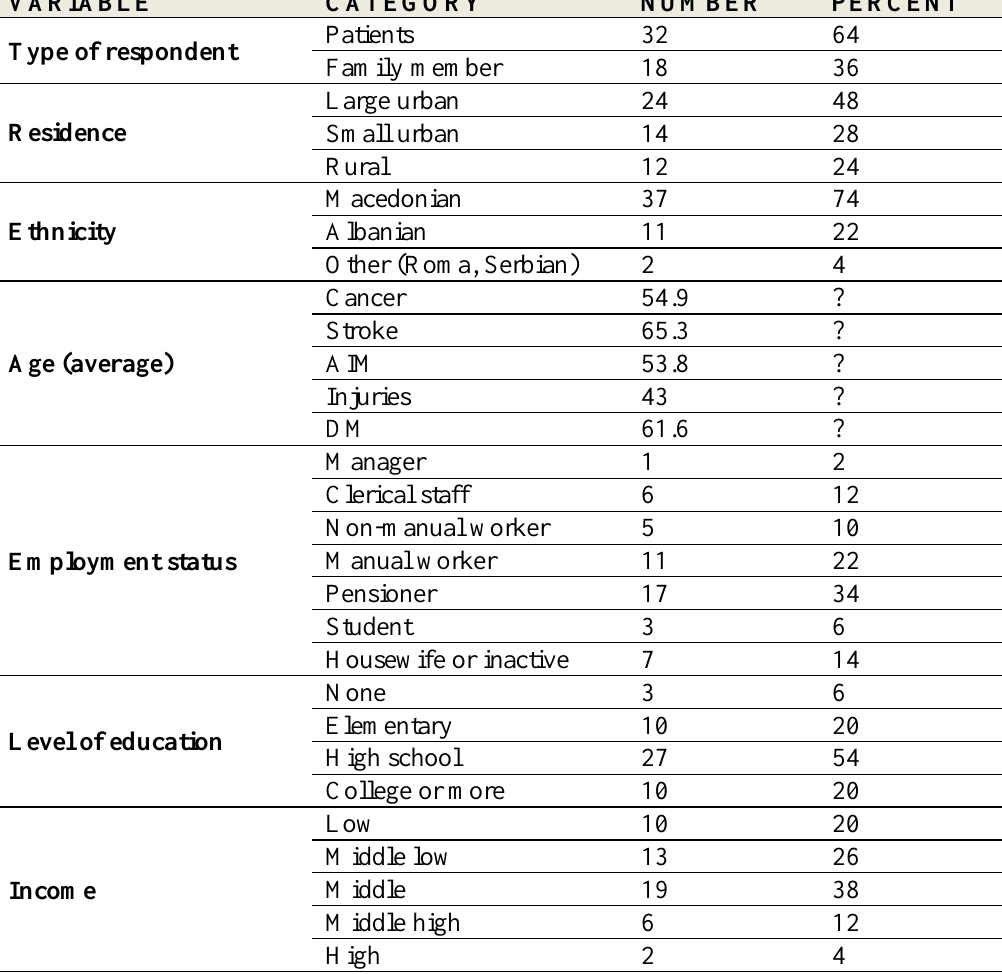
Table 1. Demographic characteristic of individual